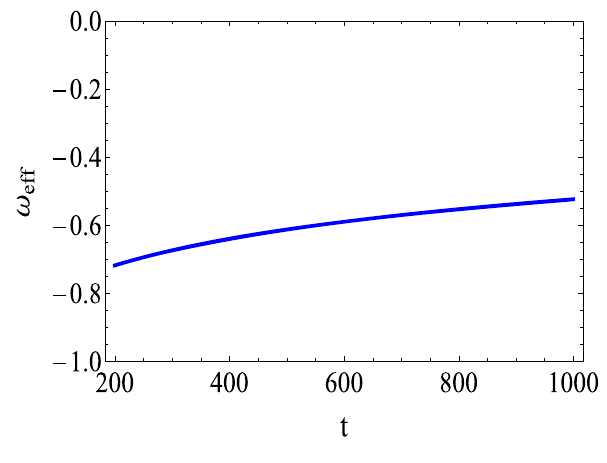
Fig. 8 The trend of the effective equation of state parameter ω